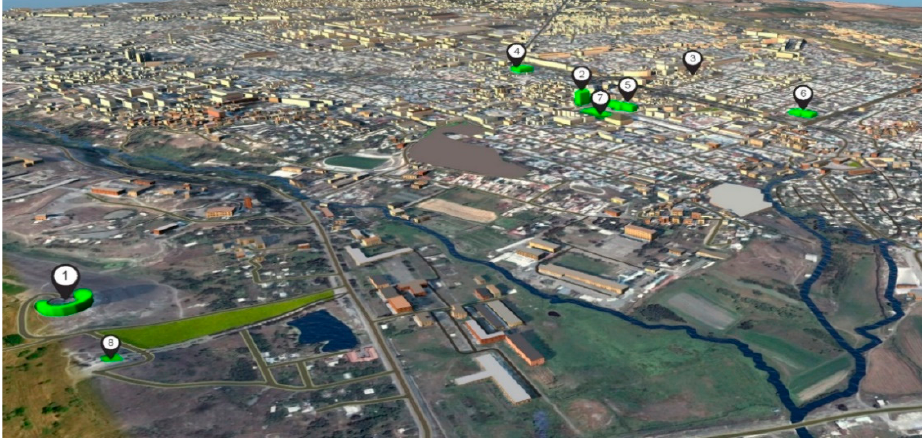
Figure 3. Visual model of Gyumri with an indication of buildings that young people find attractive and interesting.